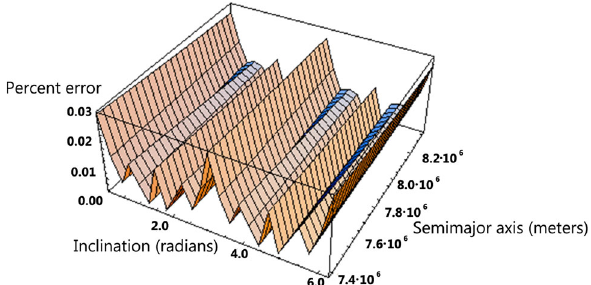
Fig. 2 Percent error in the measurement of the Lense-Thirring effect, due to the even zonal harmonics uncertainties, as a function of the incli- nation and of the semimajor axis of LARES, using LARES, LAGEOS and LAGEOS 2. The range of the semimajor axis of LARES is between 7400and8300kmandthatoftheinclinationbetween0and2 π [adapted from